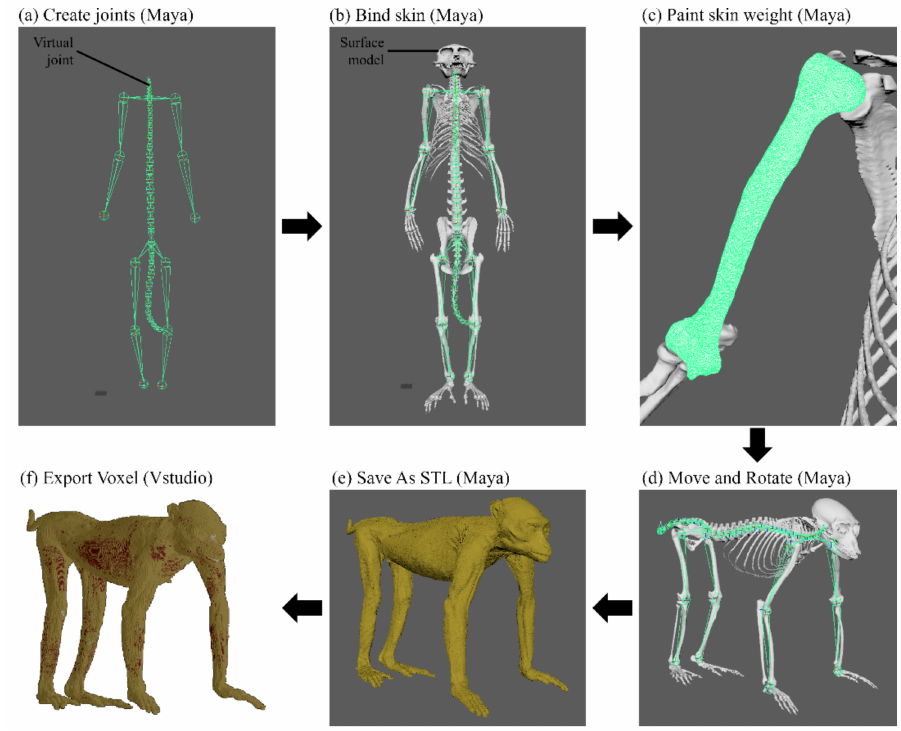
Figure 1. Overall process of changing positions from the monkey surface models to voxel models. ( a ) 52 virtual joints were created using the Create Joints tool in Maya. ( b ) Surface models of the monkey were bound to the virtual joints using the Bind Skin tool in Maya. ( c ) The shape of the surface models was set to anatomically correct using the Paint Skin Weight tool in Maya. ( d ) The anatomical position of the monkey surface models were changed to a quadrupedal position using the Move and Rotate tools on virtual joints in Maya. ( e ) The surface models were saved in STL format in Maya. ( f ) The surface models of the quadrupedal position were converted into voxel models using the Export Voxel tool in